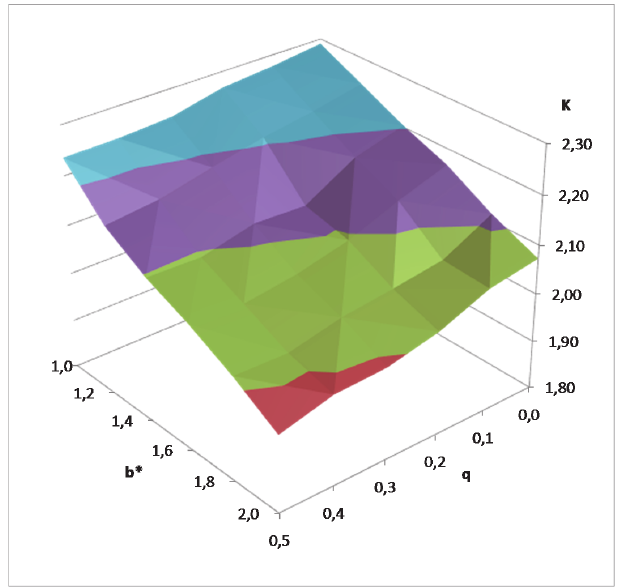
Fig. 4. The behaviour of